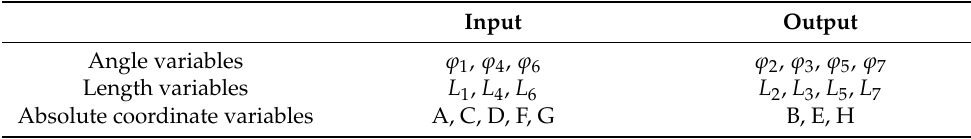
Figure 2. Configuration design of truss-link mechanism in ( a ) stowed configuration ( b ) deployed configuration with latching points: B, E, H. Table 2. Design variables of the truss-link mechanism.